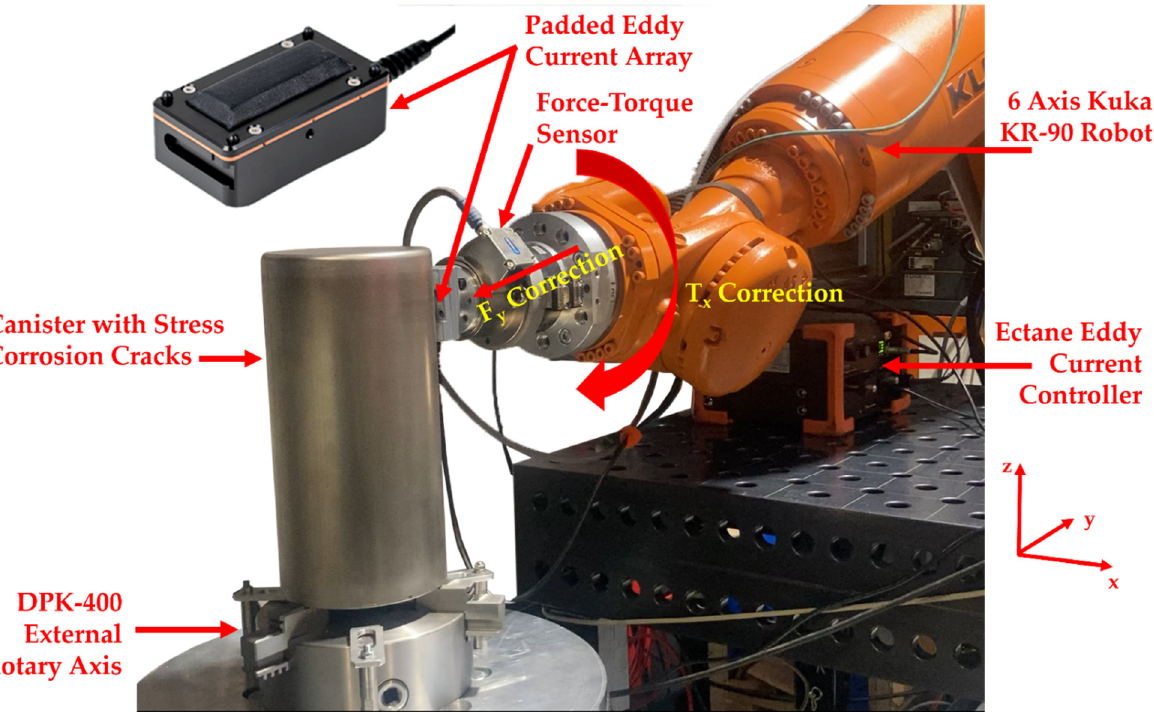
Figure 1. Eddy current inspection